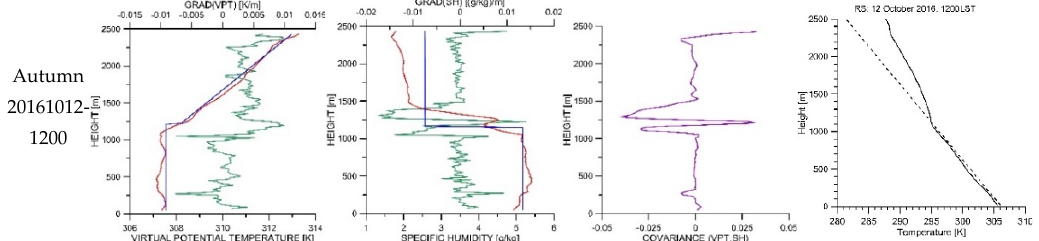
Figure 9. Application of the LSVA, GM, CM, and PM to the VPT, SH, and T profiles of the 12:00 LST of October 12, 2016. First column: LSVA/VPT and GM/VPT. Second column: LSVA/SH and GM/SH. Third column: CM. Fourth column: PM.